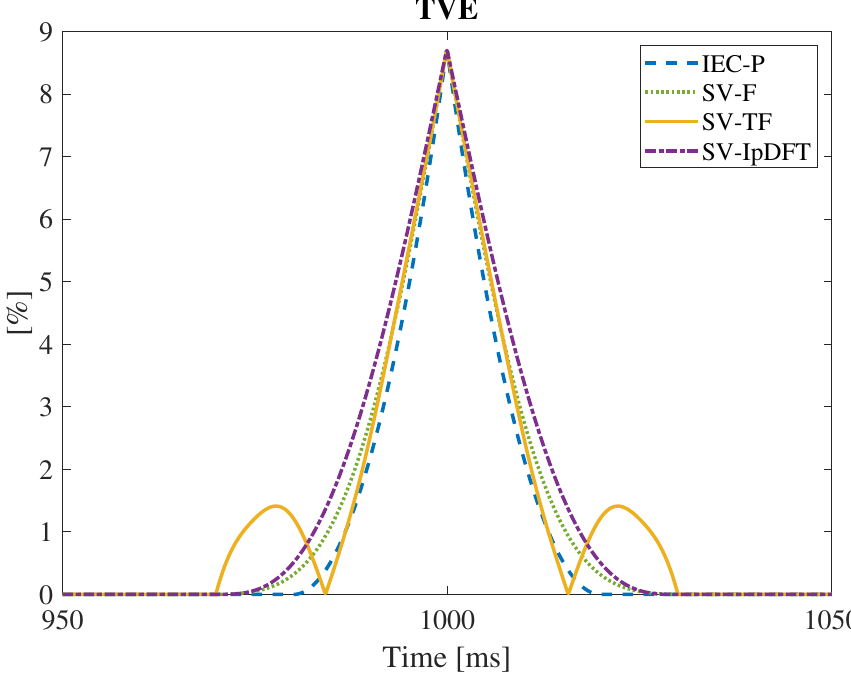
Figure 22. Positive sequence synchrophasor phase angle estimation, − 10 ◦ phase step.